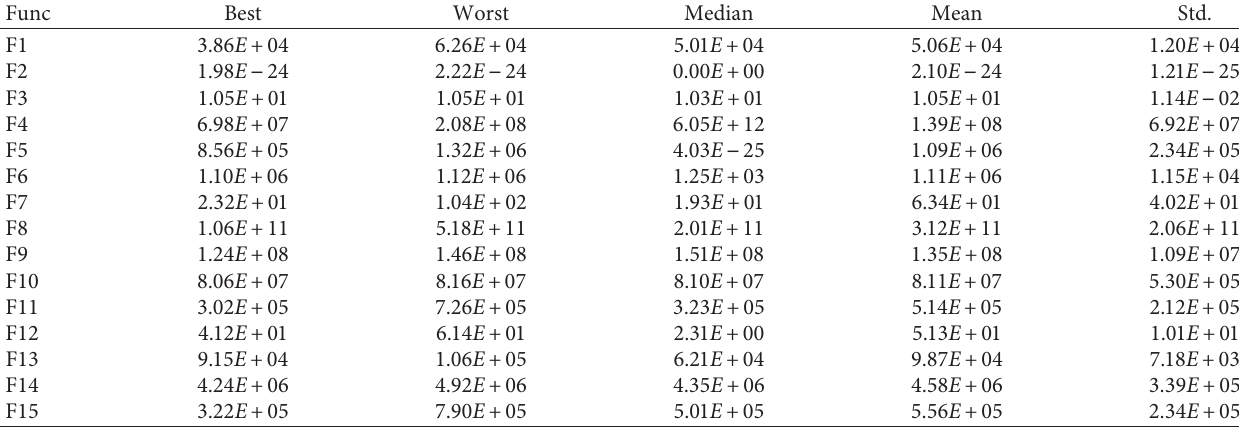
Table 3: GI-ES statistical results using CEC2013, the statistical results for all functions include best, worst, median, mean, and standard deviation calculated over 25 runs.